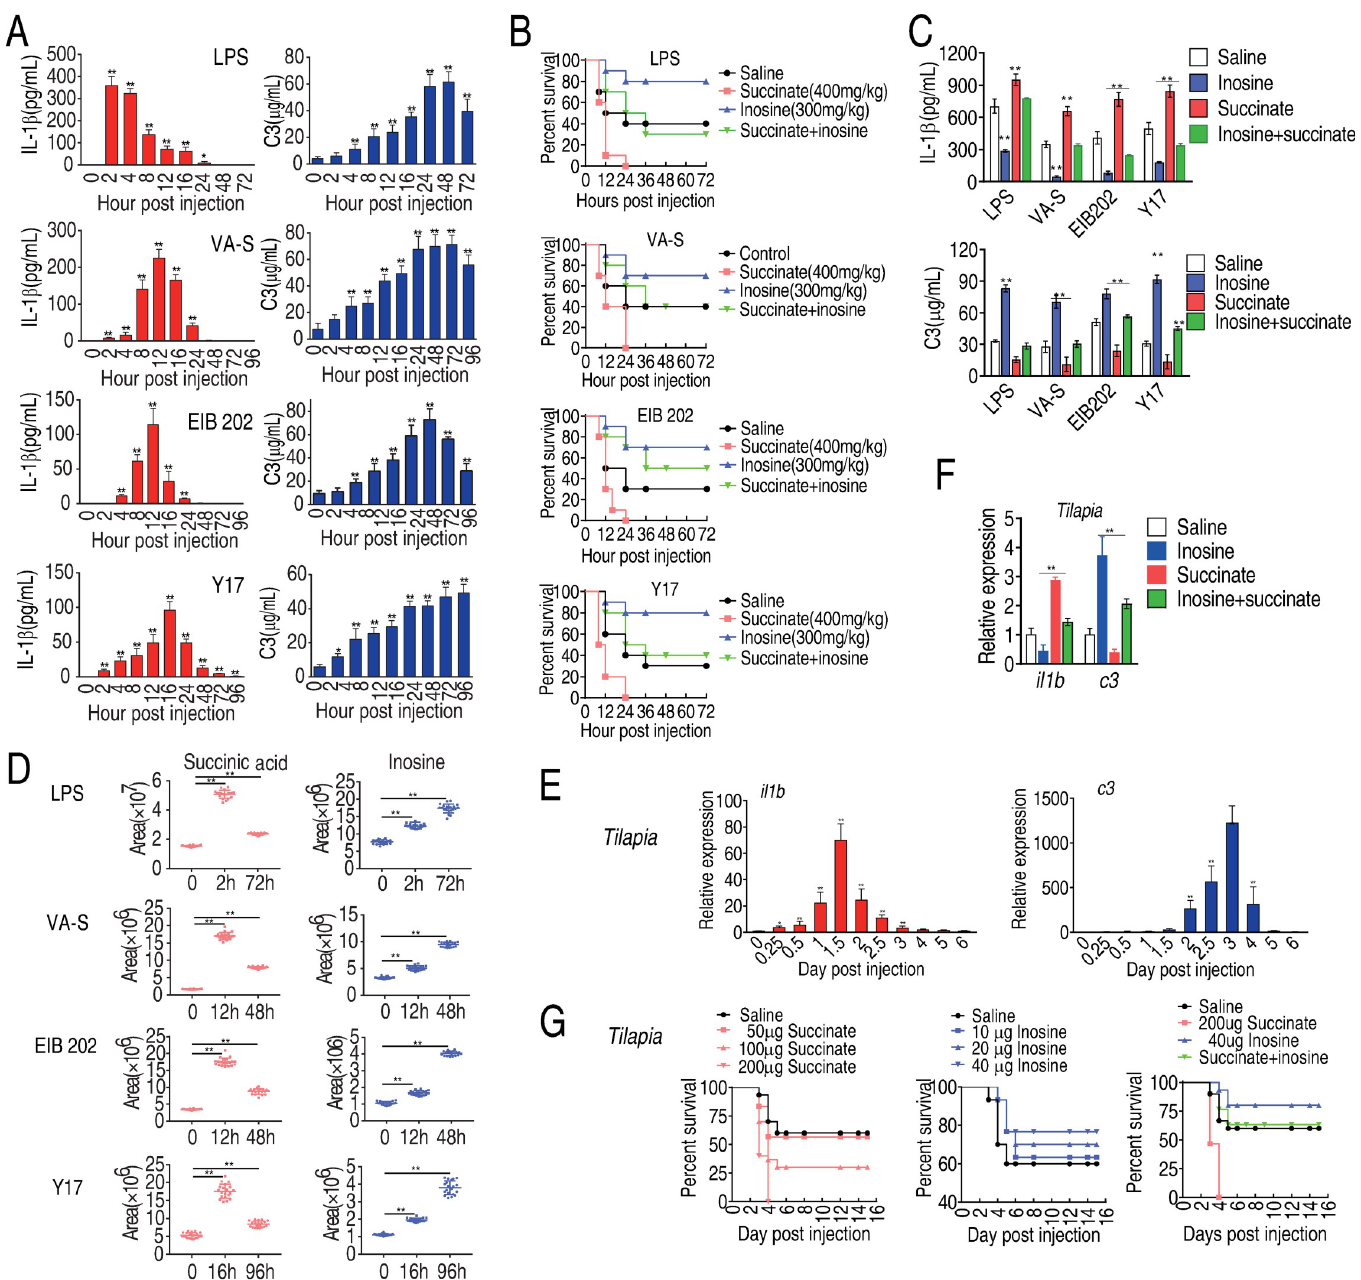
Fig 6. Animal model studies of the impact of succinate and inosine on survival after challenge with bacterial pathogens. A, Quantification of serum level of IL-1 β and C3 in mice at the indicated time points after injection with LPS, V . alginolyticus (VA), E . tarda EIB202 (EIB202) or E . coli Y17 (Y17), as described in Methods. B, Percent survival of mice co-injected with LPS or the indicated bacterial pathogen and succinate or inosine or both, as indicated. C, Serum abundance of IL-1 β and C3 in mice co- injected with LPS or the indicated bacterial pathogen and succinate or inosine or both, as indicated. D, Abundance of inosine or succinate at the indicated time point in mice injected with LPS or the indicated bacterial pathogen. E, Abundance of IL-1 β and C3 at the indicated time point after injection of tilapia with E . tarda (EIB202), as described in Methods. F, Abundance of IL-1 β and C3 in tilapia co-injected with EIB202 and saline, succinate or inosine or both, as indicated. G, Percent survival of tilapia co-injected with EIB202 and the indicated amount of succinate or inosine or both. Results (A-F) are displayed as mean ± SEM, and significant differences are identified ( � p < 0.05, �� p < 0.01) as determined by non-parametric Kruskal-Wallis one-way analysis with Dunn multiple comparison post hoc test for results (A, C-F) and Kaplan- Meier method with log-rank test (B and